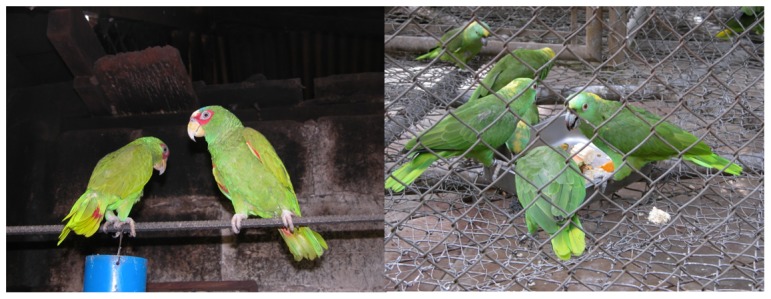
White-fronted (Amazona albifrons, left) and yellow-napped amazons (Amazona auropalliata, right) are often kept as household pets in Mexico and other Central American countries.About 8,000 and 1,000 individuals were illegally captured per year, respectively, in Mexico [18]. The yellow-napped amazon was listed by IUCN as Vulnerable in 2012 due to a rapid population decline (photos taken by J.L. Tella in Guatemala, 2005).